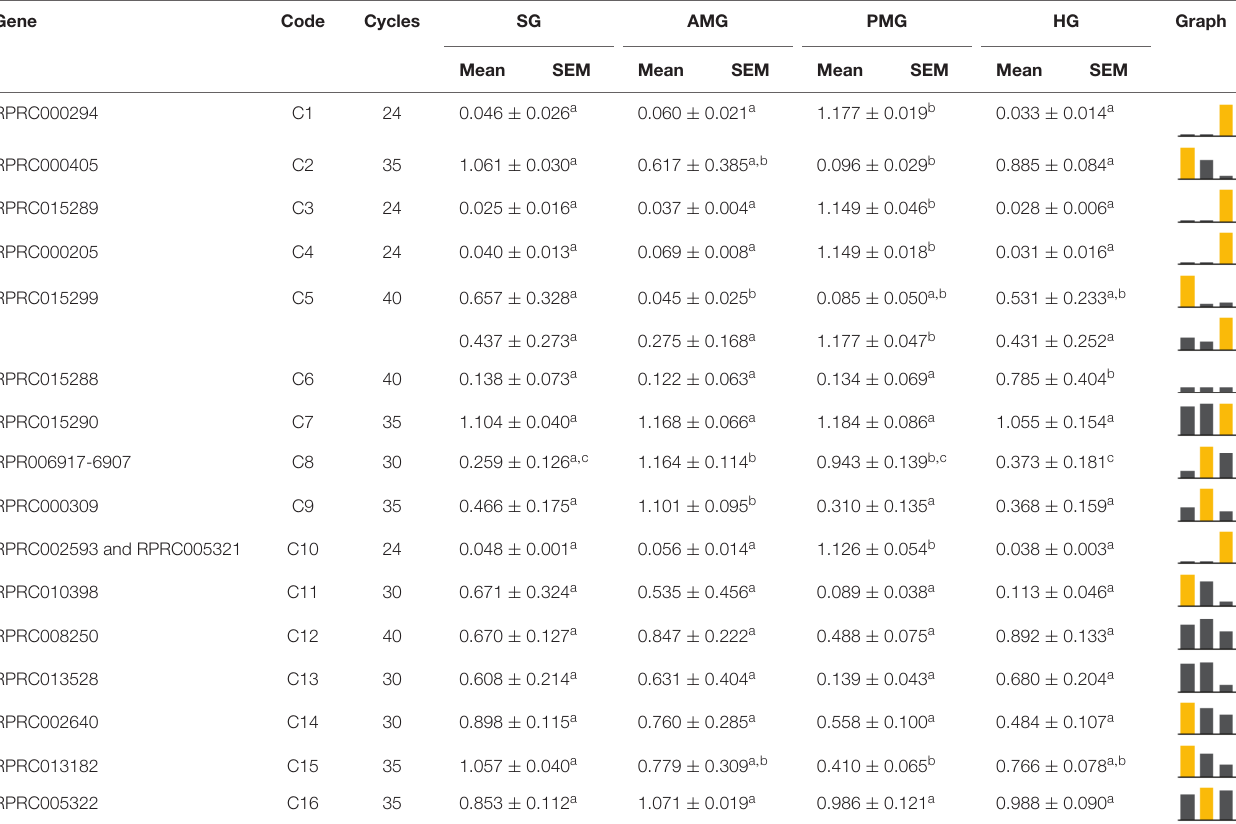
TABLE 4 | Relative expression patterns of genes from protease family C1 in the tissues of Rhodnius prolixus adult males. Gene Code Cycles SG AMG PMG HG Graph Mean